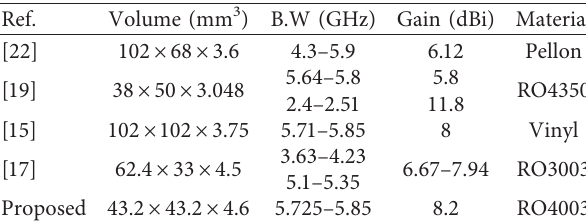
Table 1: Comparison of the proposed integrated antenna with previous